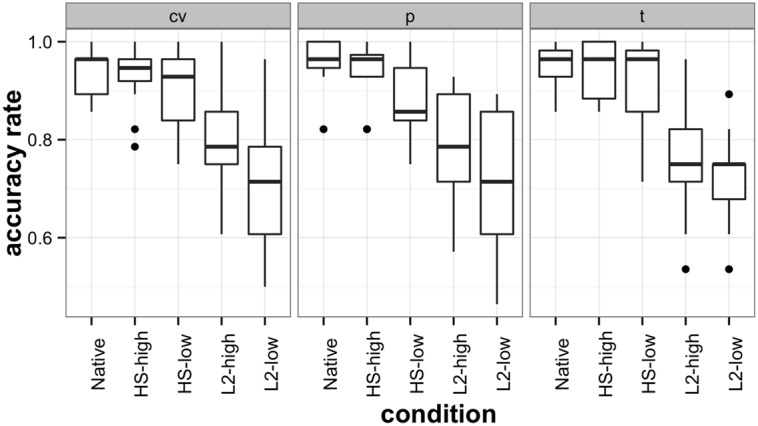
AXB discrimination task accuracy scores across all groups. The labels ‘cv’, ‘p’, and ‘t’ represent the three critical conditions, the C’VC-CjVC, final /p–p’/, and /t–t’/ consonants.